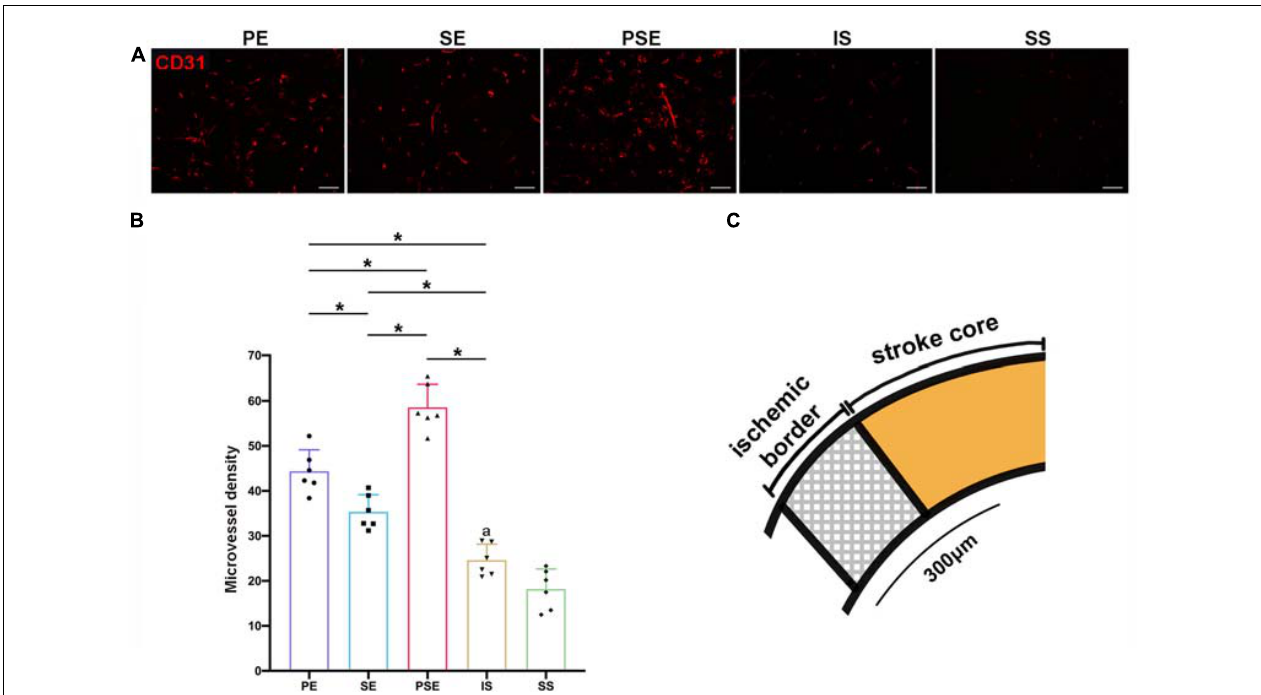
FIGURE 4 | Microvessel density (MVD) in the peri-infarct cortex at 14 days after MCAO. (A) Representative images of immunofluorescent labeling of CD31 in the periinfarct area. Bar = 50 µ m. (B) Quantitative analysis of microvessel density (MVD). n = 6. Data are expressed as mean ± SEM; * P < 0.05. (C) Schematic brain with a highlight of ischemic